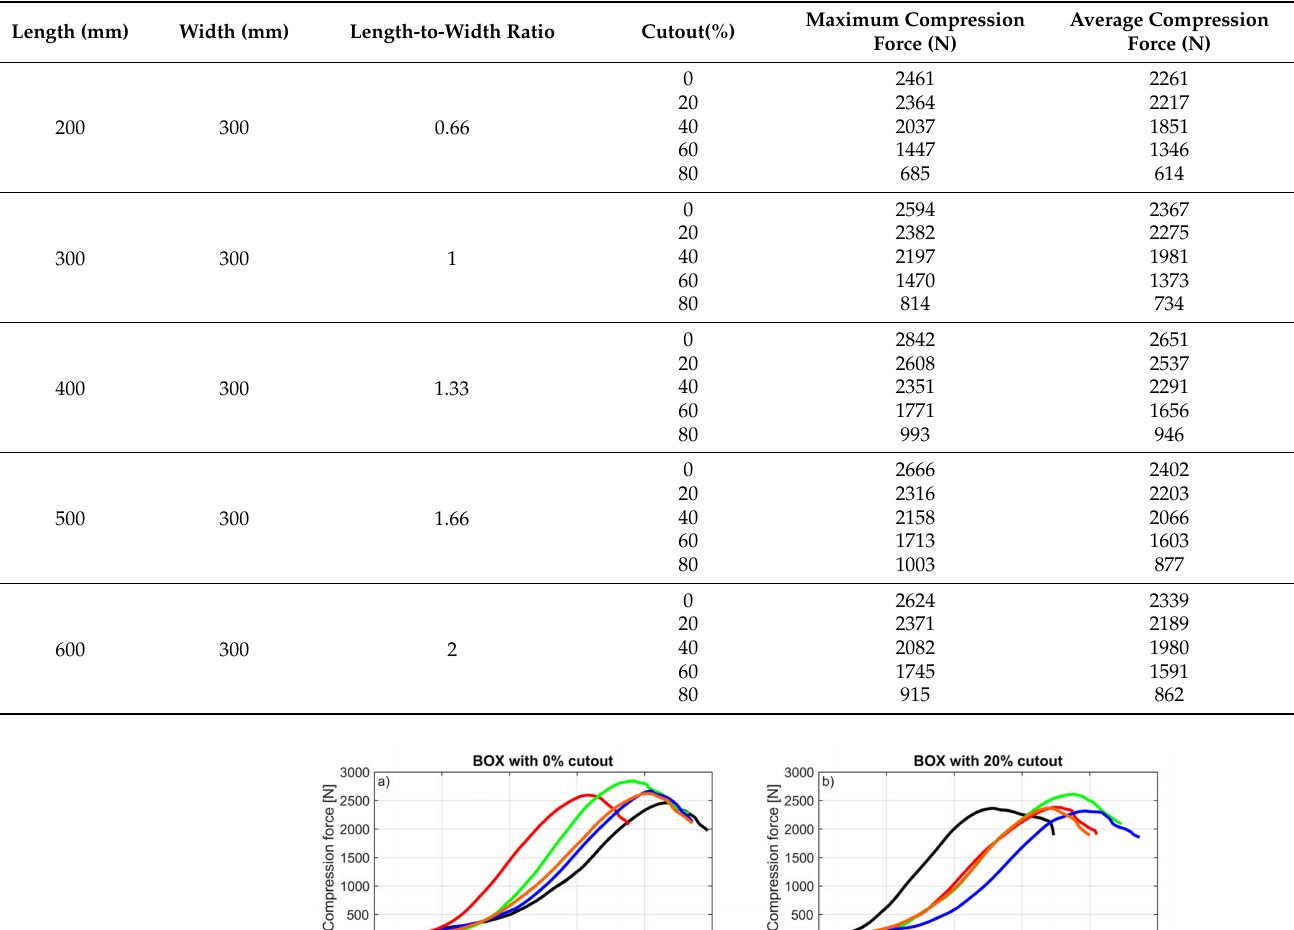
Table 3. Summary table of measurement results.